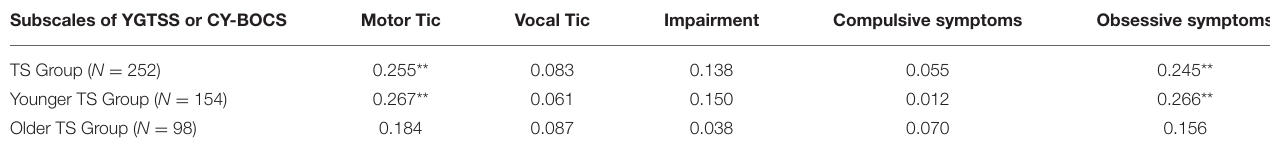
TABLE 4 | The Pearson correlation analysis between the subscales of YGTSS, CY-BOCS and PUTS in TS groups. Subscales of YGTSS or CY-BOCS